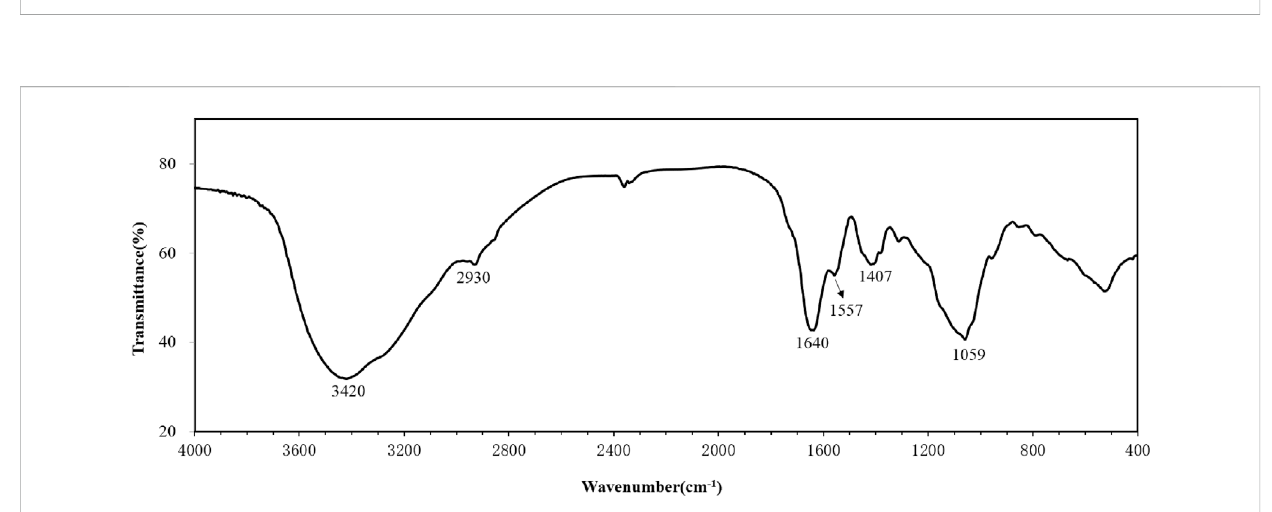
FIGURE 1 The monosaccharide composition of the bio fl occulant detected by ion chromatography.